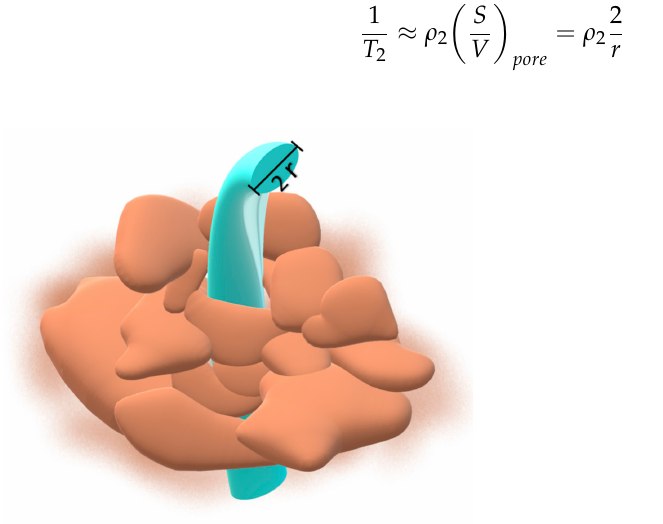
Figure 5. Pores size schematic diagram. The diagram shows a schematic pore throat indicating the pore throat radius.